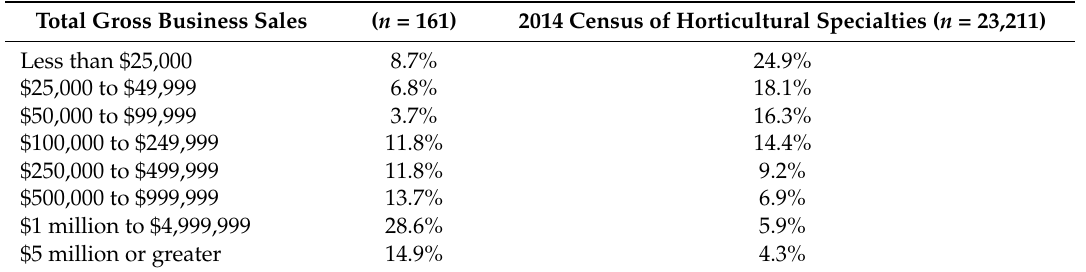
Table 1. Total gross business sales in 2014 of the ornamental horticulture industry respondents in the study.